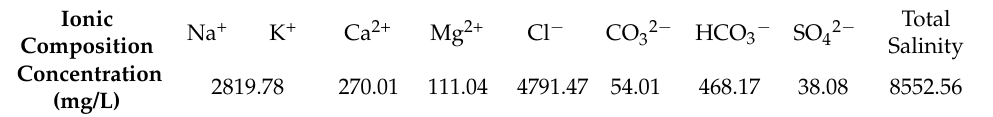
Table 1. Composition of ion in the synthetic